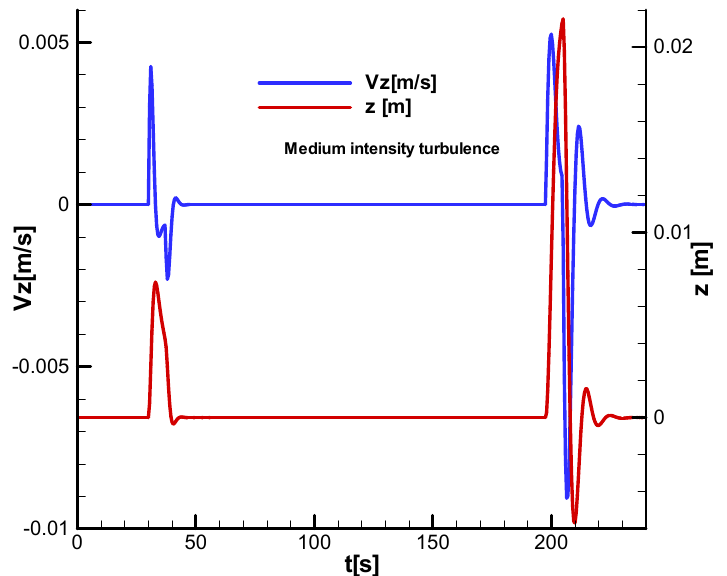
Figure 29. Influence of turbulence on the lateral coordinate ( z ) and lateral velocity ( Vz ).